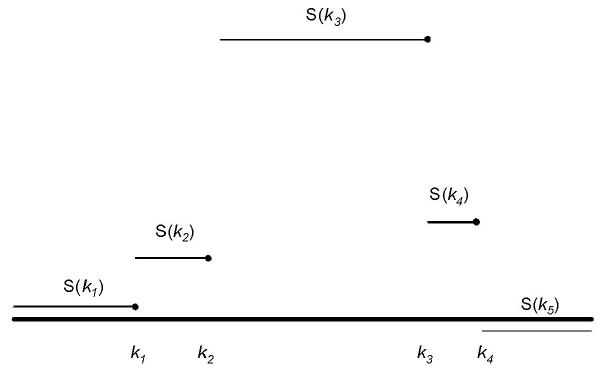
Figure 3. Illustration of cleanup step. As the backward elimination step has terminated, each jump is larger than the appropriate cutoff. At the start of the cleanup step, S ( k 1 ) and S ( k 3 ) would be set to zero, decreasing b ( k 3 ) ~ j j S ( k 4 ) { S ( k 3 ) j j and hence making it a candidate for removal if it becomes smaller than the appropriate